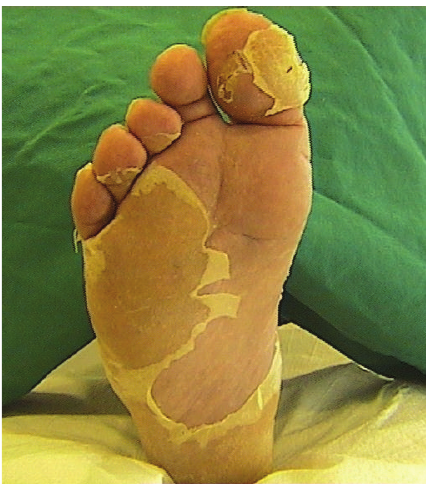
Figure 1: Erythematous desquamation of the right planta pedis, of a 40-year old patient who was treated with an antiretroviral combination therapy and developed plantar